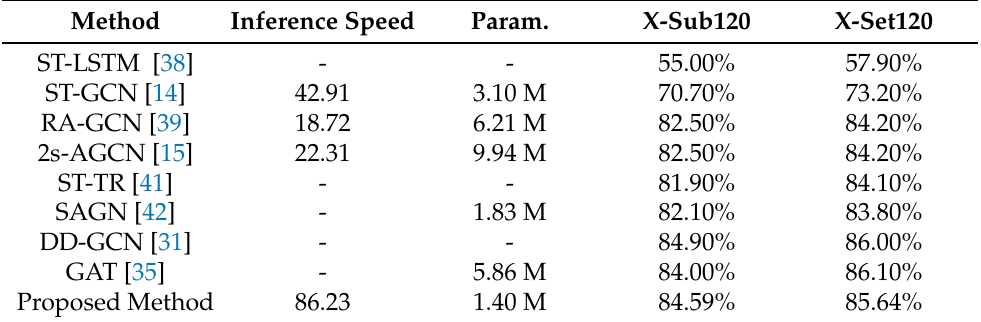
Table 2. Comparison of accuracy with mainstream methods on the NTU-RGB+D 120 dataset. Infer- ence speed (sequences/(second × GPU)).